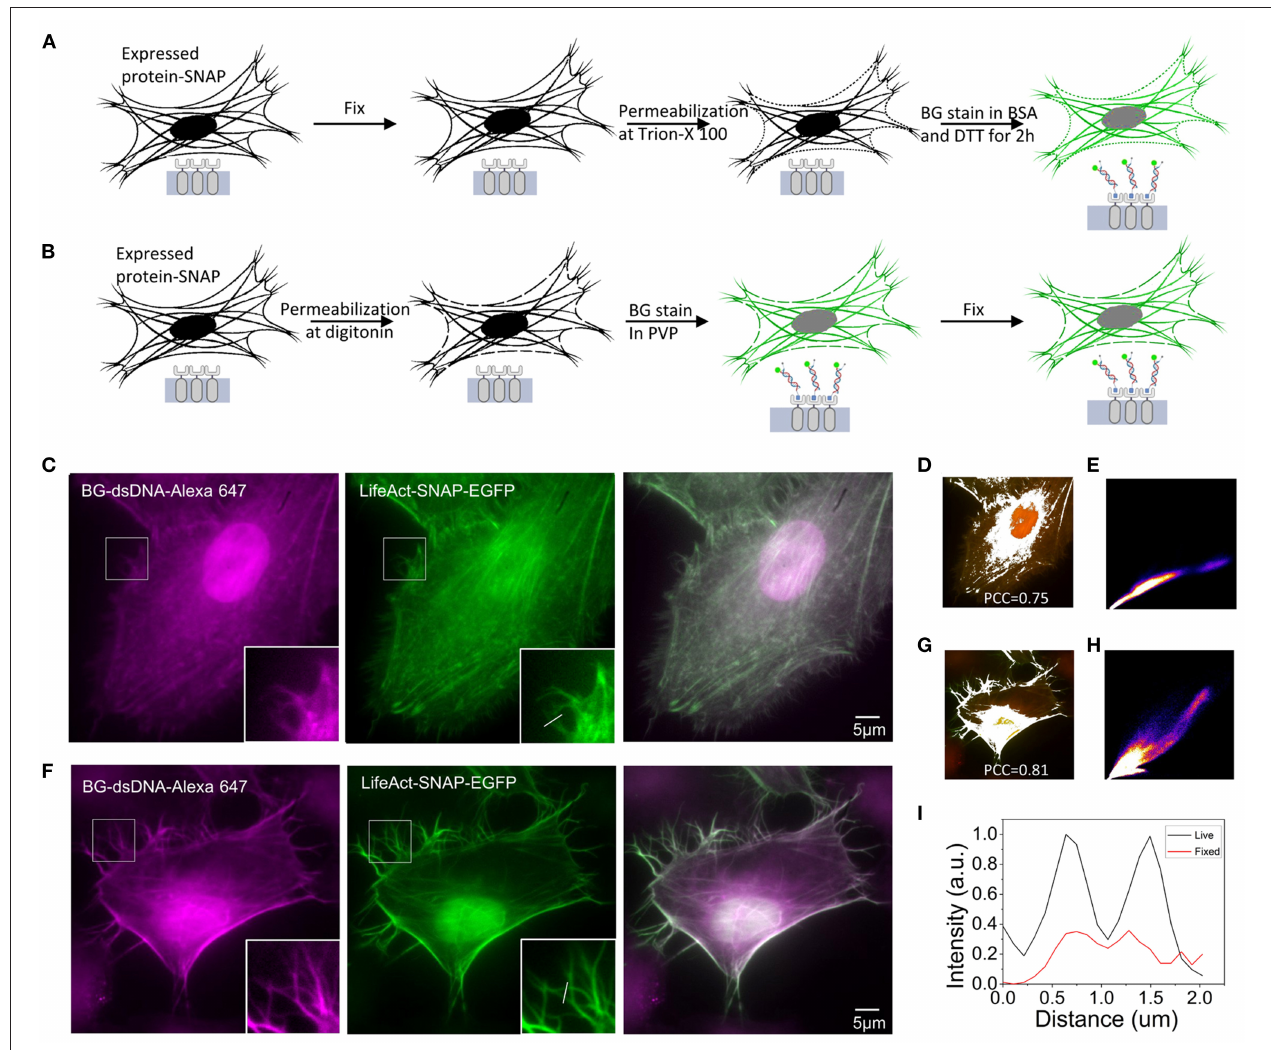
FIGURE 2 | Comparison of F-actin staining using two methods in Hela (A) Schematic diagram of the process of staining after cell fixation. (B) Schematic diagram of the process of staining and then fixing cells. (C) Staining of F-actin with benzoylguanine (BG)-dsDNA-Alexa647 after fixation. (D) Simulation effect diagram of the co-location of the two channels in (C) . The Pearson correlation coefficient (PCC) is 0.75. (E) Distribution of the correlation scatter plot of the two channels in (C) . (F) Staining of F-actin with BG-dsDNA-Alexa647 before fixation. (G) Simulation effect diagram of the co-location of the two channels in (F) The Pearson correlation coefficient (PCC) is 0.81. (H) Distribution of the correlation scatter plot of the two channels in (F) . (I) Corresponding line-scanning profile from the images (C,F) . Scale bars, 5 µ